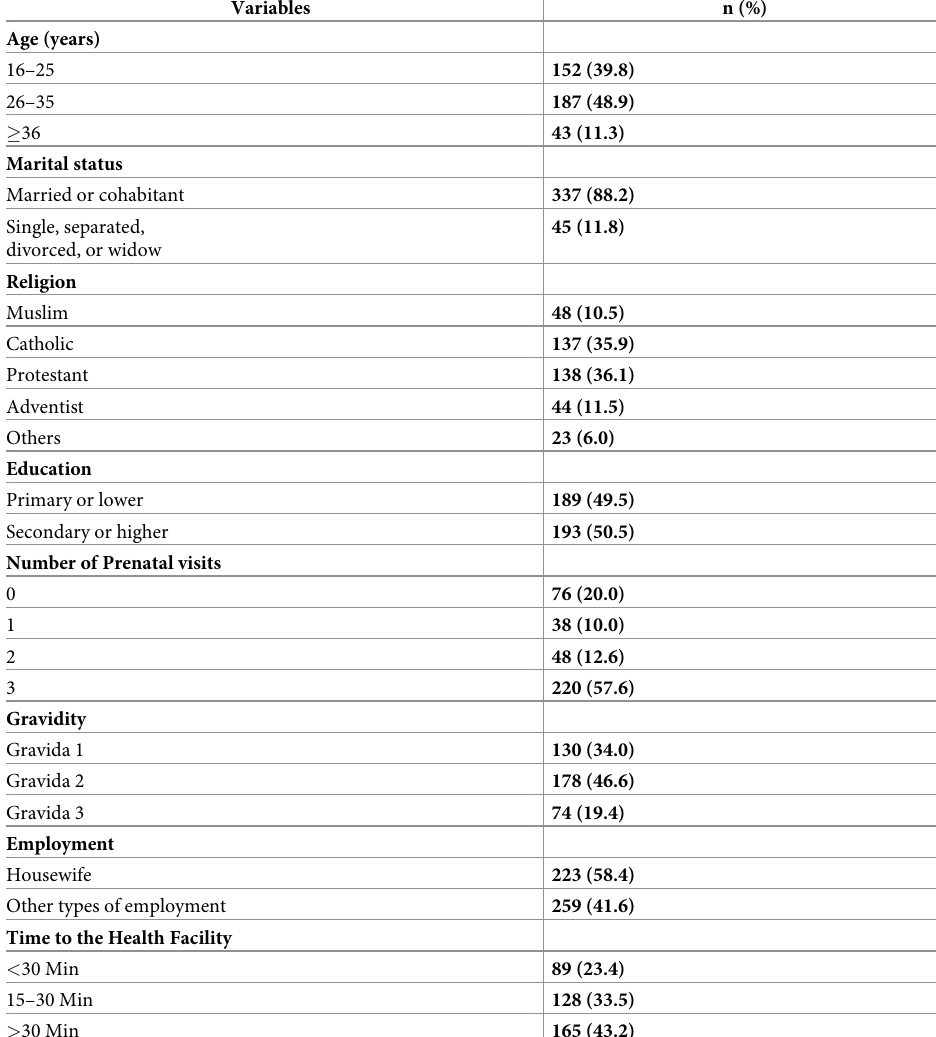
Table 1. Demographic characteristics of participants (n =